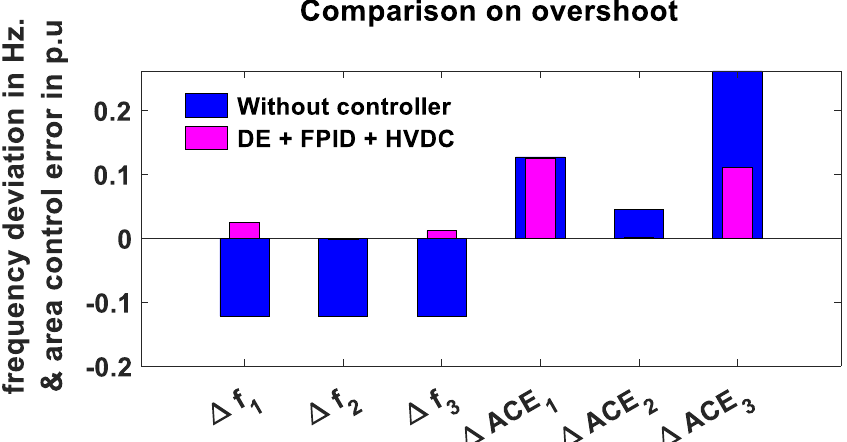
Figure 17. Comparison of controller and without controller for undershoot for frequency deviation and area control error.